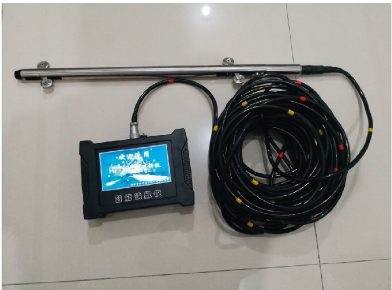
Figure 8: Photograph of the inclinometer used in engineering.